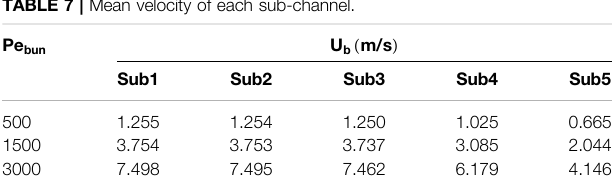
TABLE 7 | Mean velocity of each